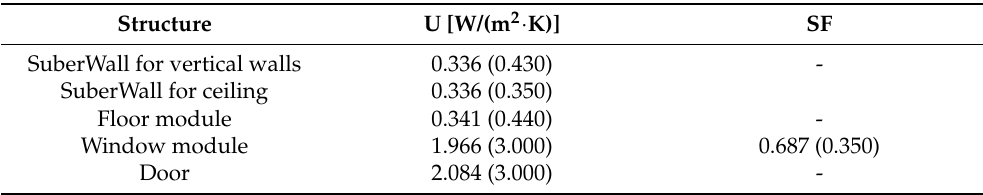
Table 4. Thermal transmittances, normal solar factor and threshold values for the various envelope